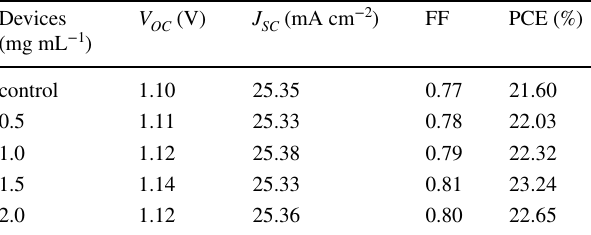
Table 1 Summary of the photovoltaic parameters of the hybrid PSCs with different concentrations of BBF additives V OC Devices (mg mL −1 )